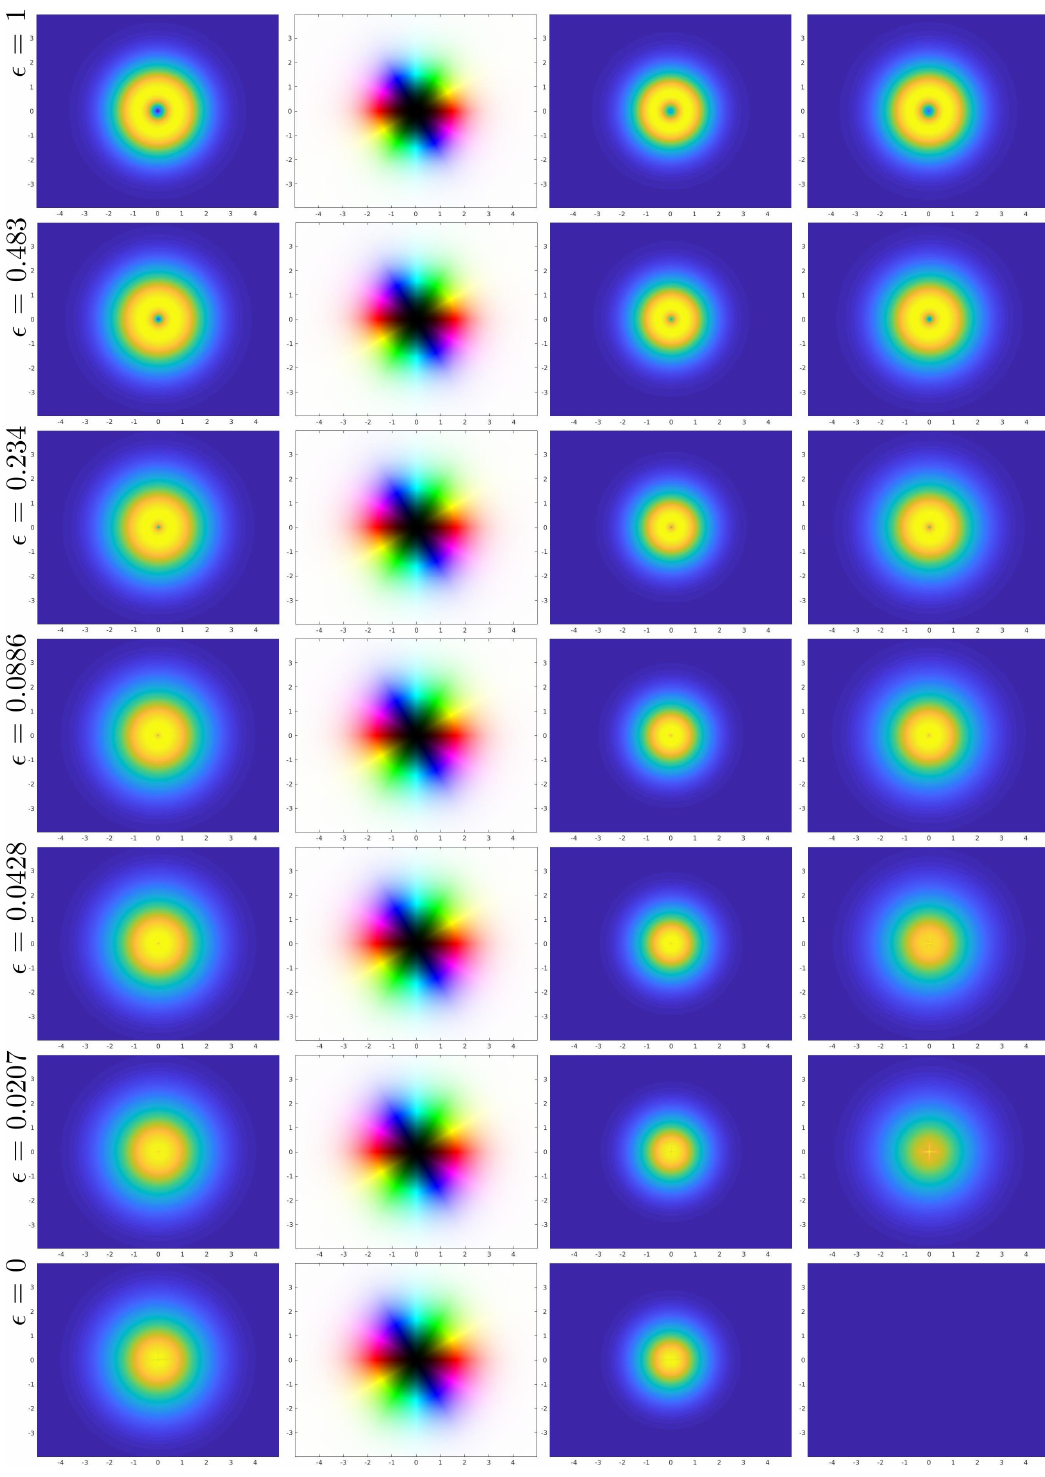
Figure 9. The Q = N = 2 baby Skyrmion for various values of (cid:15) . The columns show the topological charge density, the pion vector orientation using a color scheme described in the text, the total energy density and the perturbation energy density (cid:15) ( −L